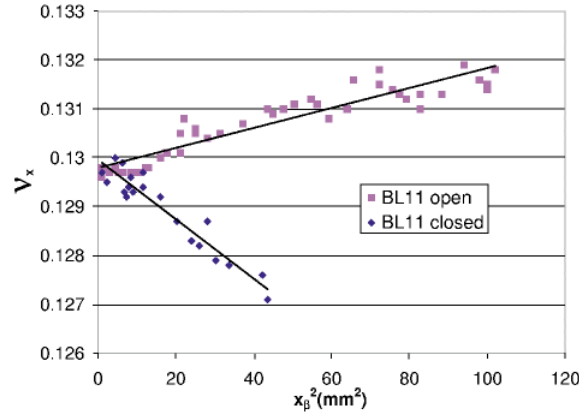
FIG. 3. (Color) Tune vs betatron oscillation amplitude without magic